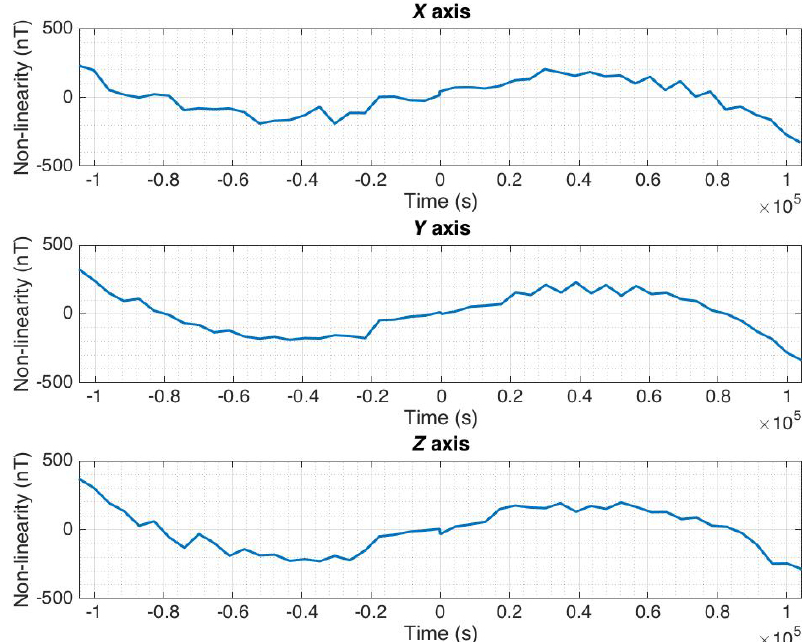
Figure 10. Nonlinearity of the sensor for each axis defined as the difference between the measured field and a linear fit to the